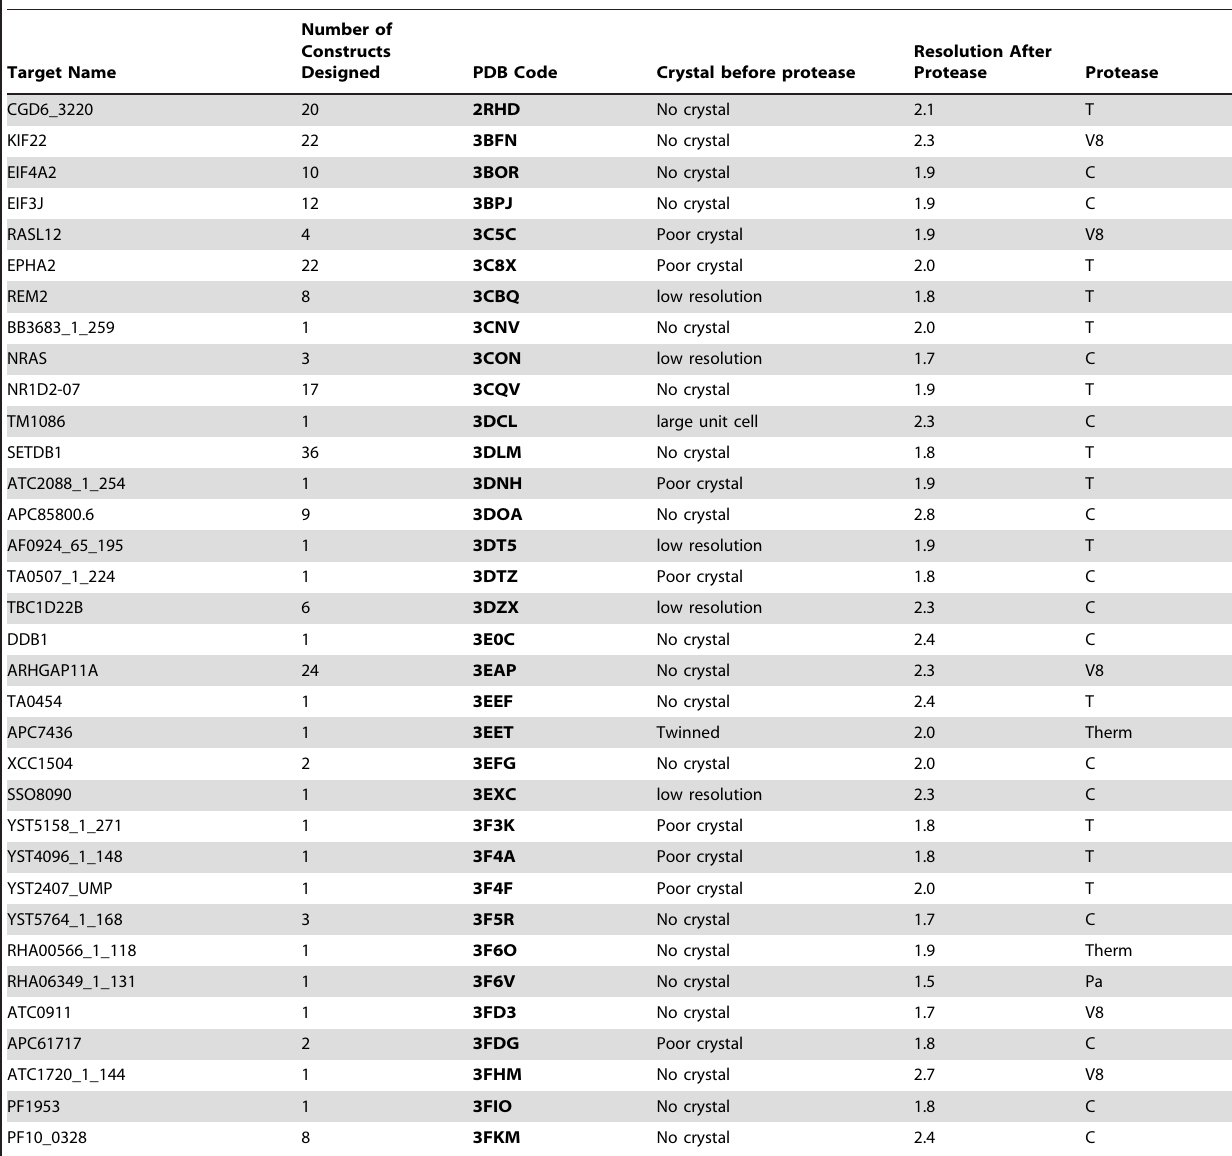
Table 1. List of deposited protein targets crystallized by in situ proteolysis.